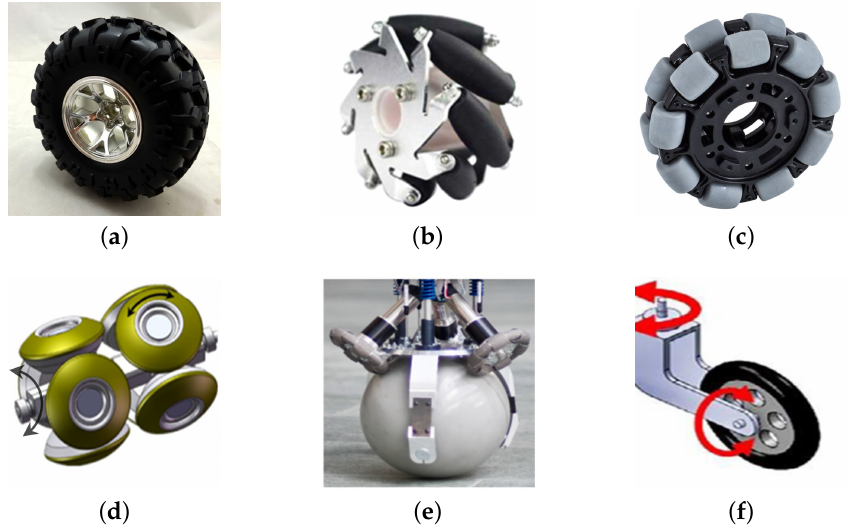
Figure 1. Varieties of wheel constructions. ( a ) Differential wheel. ( b ) Mecanum wheel. ( c ) Orthogonal wheel. ( e ) Spherical wheel. ( f ) Caster